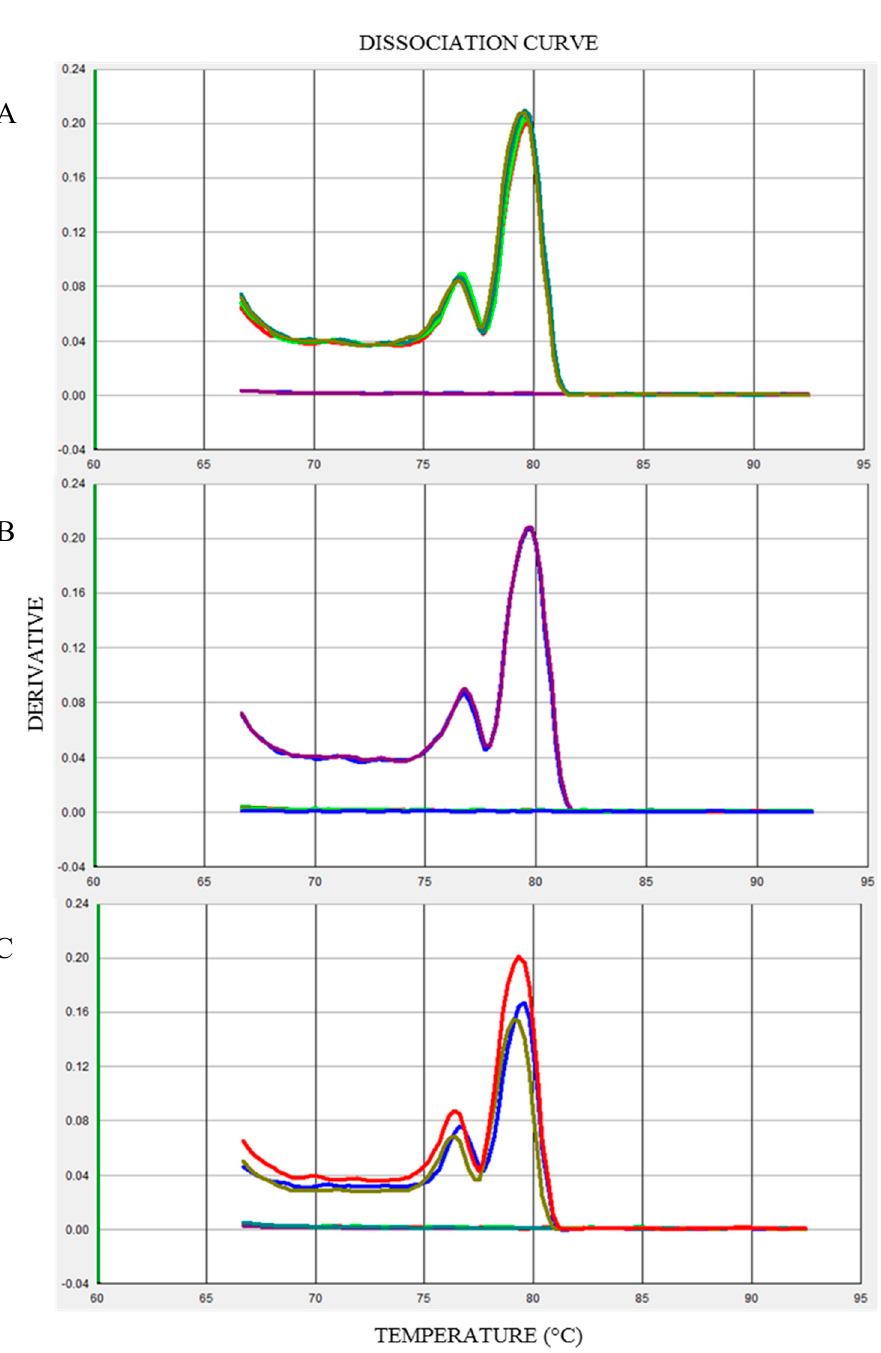
Figure 2. Real time dissociation curves to confirm mycorrhizal inoculation in ‘Pearson’ ( A ), ‘H3402 ′ ( B ) and ‘Everton’ ( C ), respectively. Single peaks are obtained from three technical replicates (each peak of different color represents a replicate). Flat lines are no template control (NTC) technical replicates.